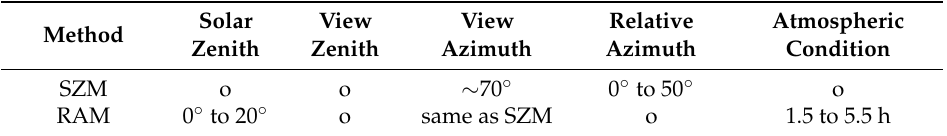
Table 1. Differences in the geometric and atmospheric conditions of the LEO and GEO observation pairs selected using the SZM and RAM methods. The mark “o” indicates that the GEO and LEO observation conditions are nearly identical. The numbers indicate the ranges of absolute differences in this study. The SZM method corresponds to simultaneous data acquisition; therefore, the atmospheric conditions will be